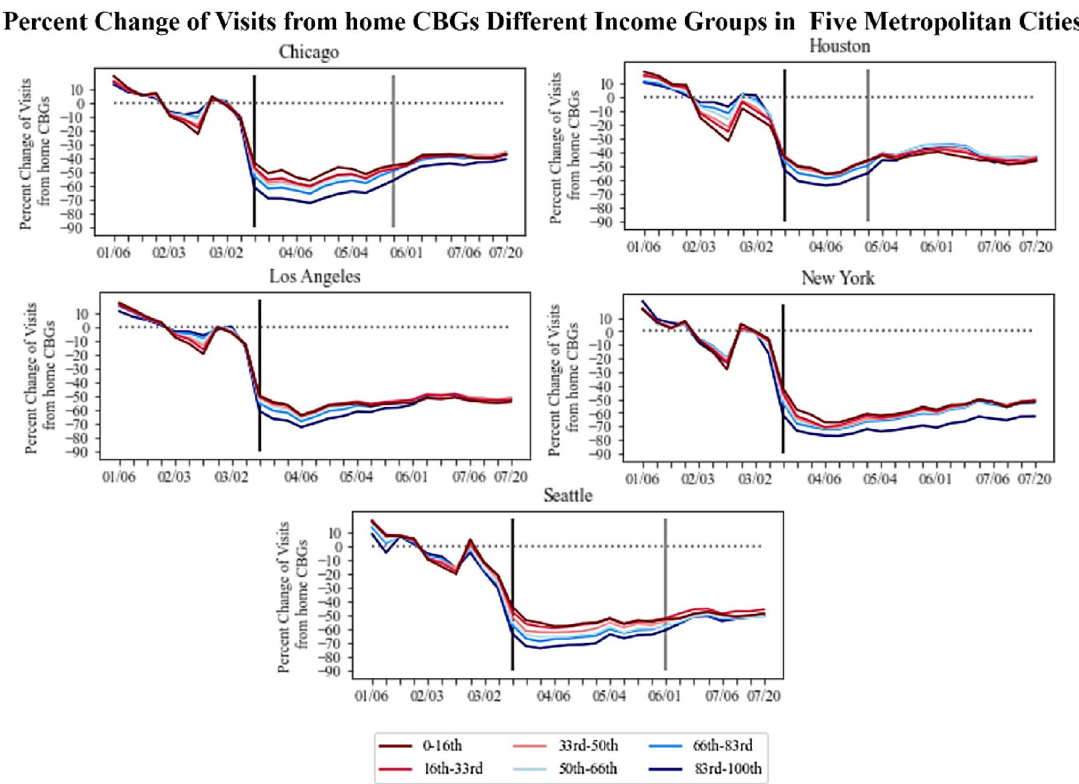
Figure 4. Percent change in POI visits between cbgs for different income groups (top) and POI percent change of total visits of POIs from home cbgs for different income groups (bottom). The percent change values of points-of-interest (POIs) are normalized for the median income levels and non-white percentage populations. The vertical black line is the week that NPI shelter-in-place was implemented in each county, and, if applicable, the vertical gray line is the week that NPI shelter-in-place was lifted. The bright red line represents the bottom 16th percentile of income (low income) while the bright blue line represents the top 83rd percentile of income (high